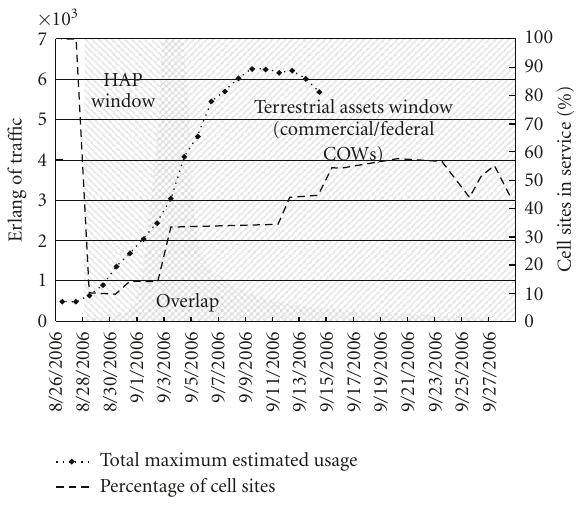
Figure 8: E ff ective disaster response windows.